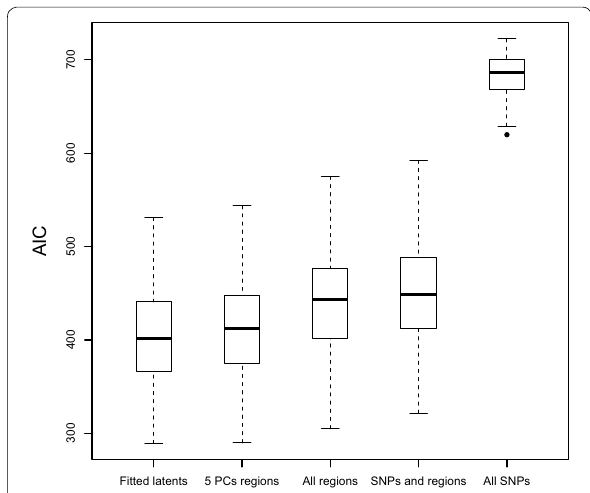
Fig. 2 Simulation AIC model fit. The logistic regression models use either the SEM estimated latent variable scores (fitted latents), the first five principal components of the brain region data (5 PCs regions), all brain region data, all SNP and brain region data, or all SNP